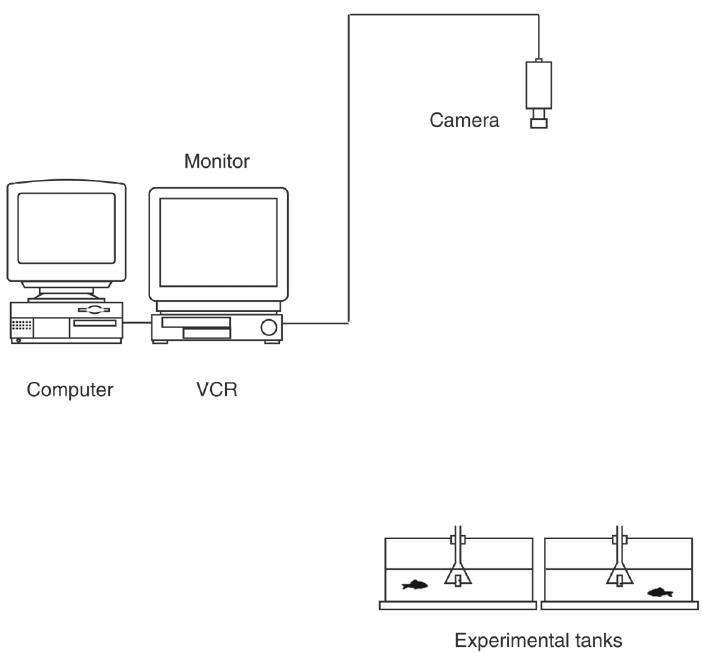
Fig. 1. The experimental set-up for tests of the swimming behaviour of crucian carp. Only two out of a total of four circular, experimen- tal tanks are shown here. The behaviour of experimental fish is recorded by an centrally placed overhead video camera linked to a computer running motion analysis